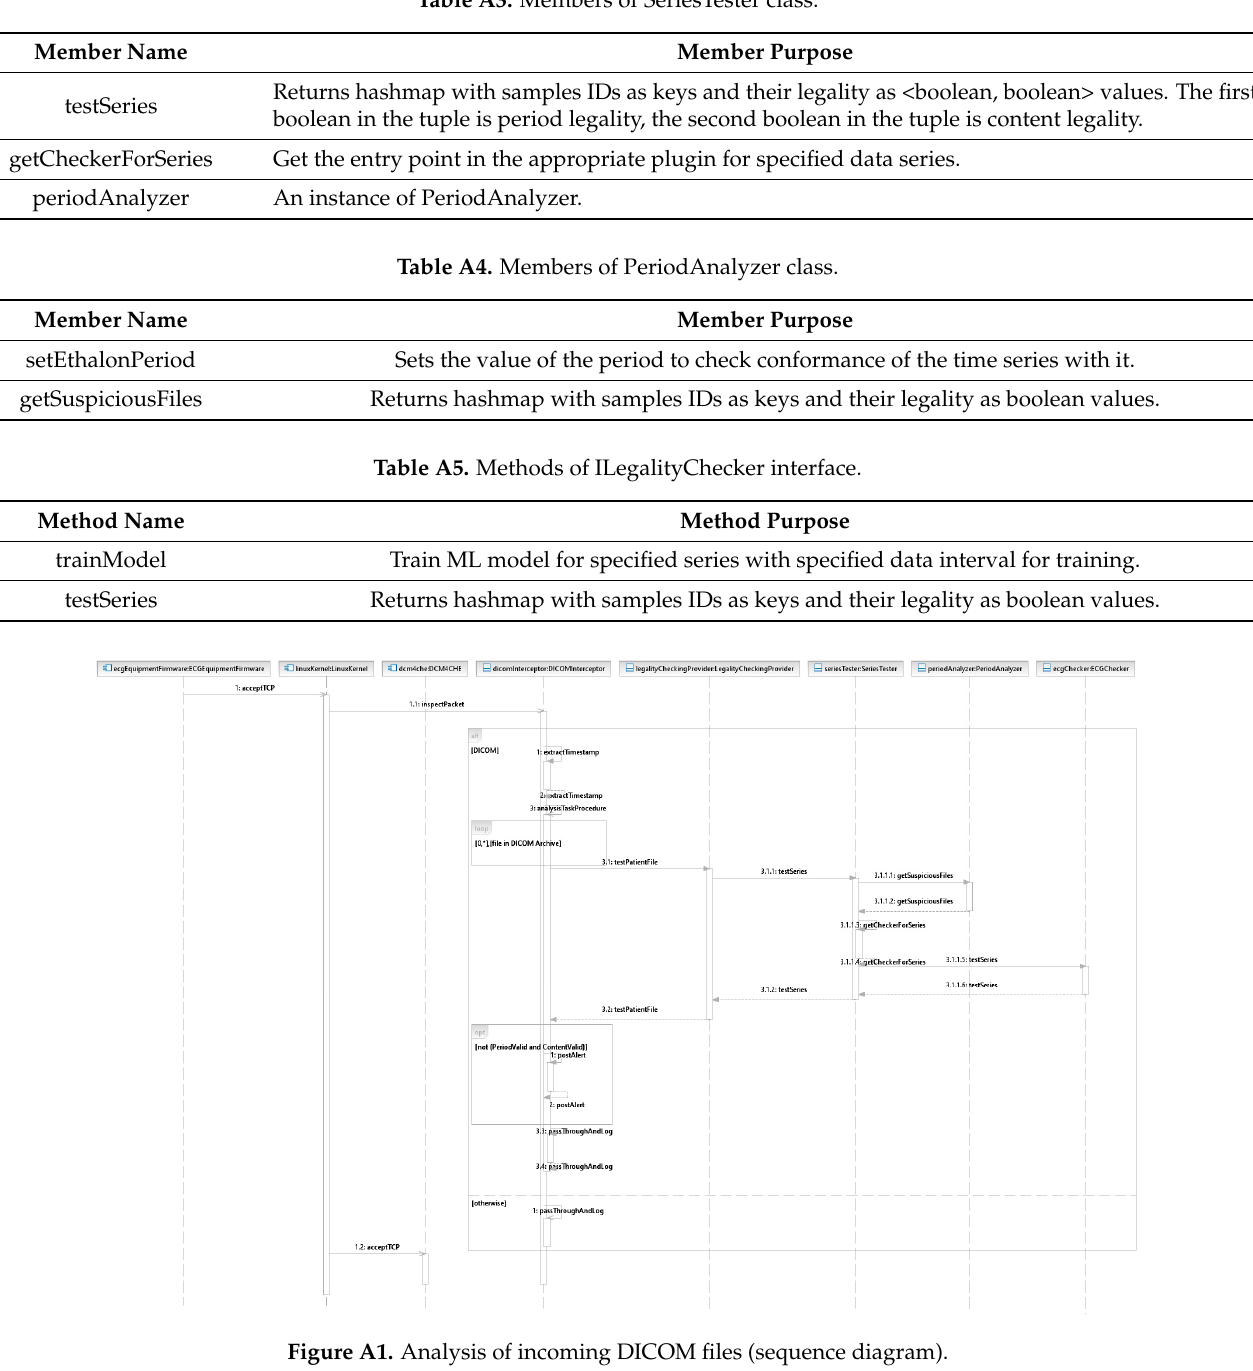
Table A3. Members of SeriesTester class.